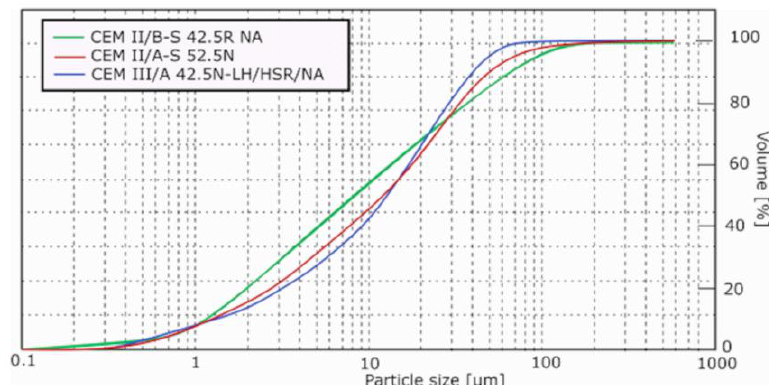
Figure 2. Particle size distribution of slag cements used in the research.